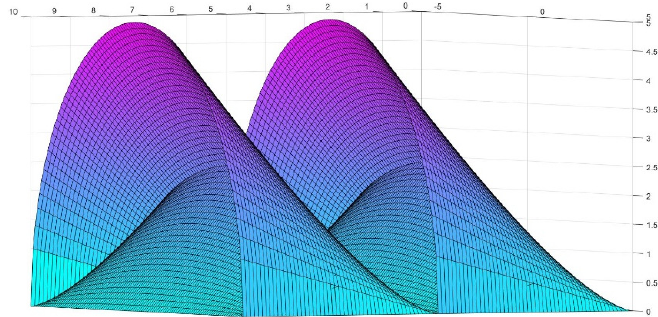
Figure 29. Outline of proposed Skylights with internal conoid glazing.